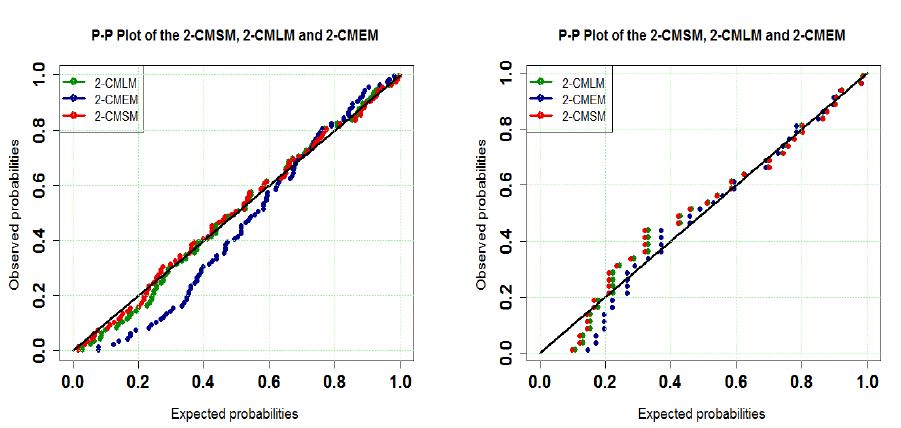
Fig. 16. Plots for the estimated PDFs and CDFs for Dataset II. Figure 16. Plots for the estimated PDFs and CDFs for Dataset II.